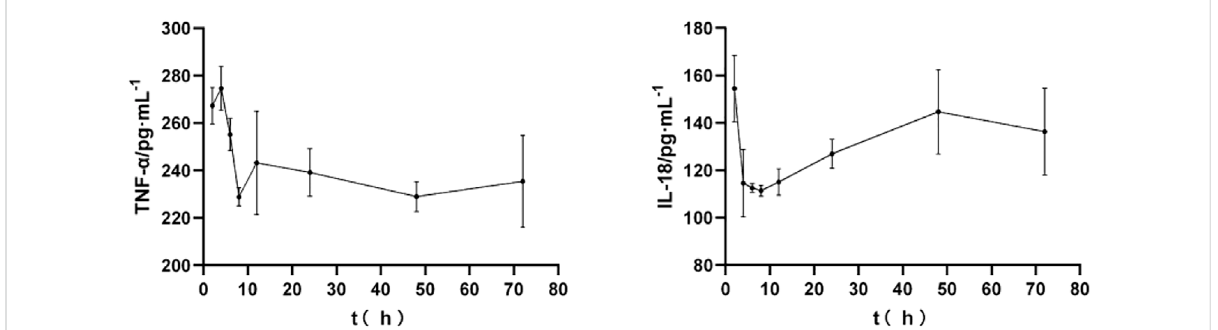
TABLE2Peakareasandpharmacodynamiccomprehensiveevaluation value at different time points ( (cid:1) x ±s, n = 6).